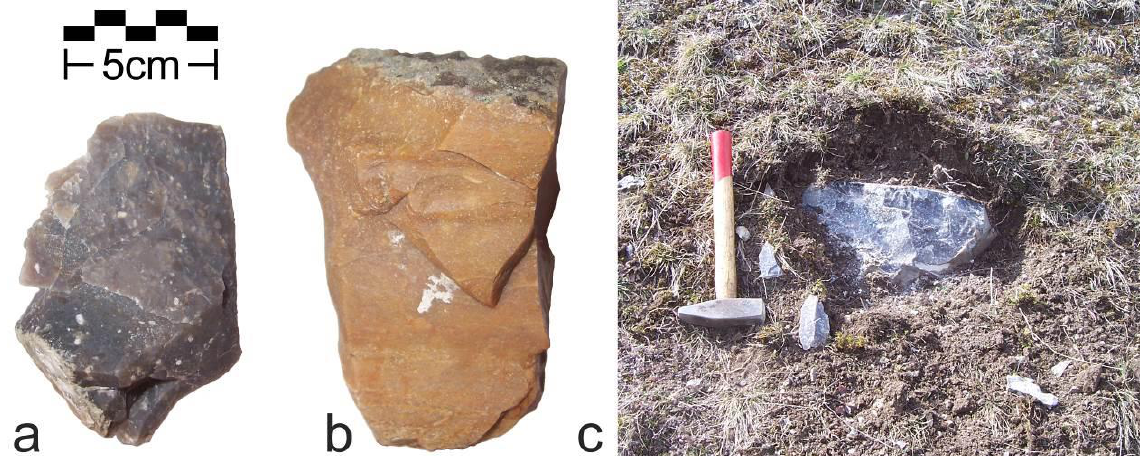
Figure 12. a) and b) Photos of chert samples from Piatra Tomii showing macroscopic variation. c) A nodule of chert in situ on the hill (the 2kg hammer in the photo is for